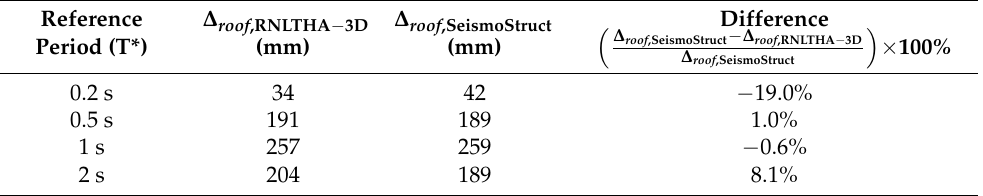
Figure A6. Comparison of the maximum displacement profile of case study building #2 obtained using RNLTHA-3D and SeismoStruct. Table A5. Comparison of maximum 3D roof displacement of case study building #2 obtained from the proposed RNLTHA-3D and SeismoStruct for the four reference periods.